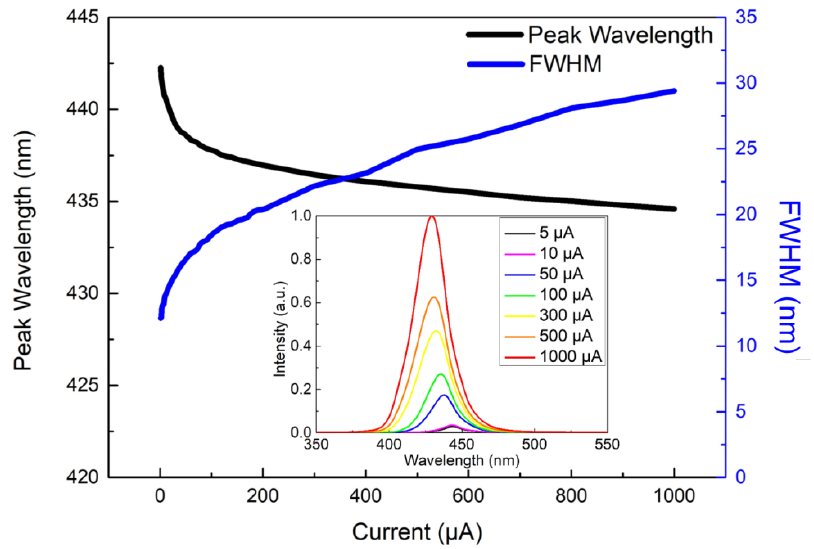
Figure 7. Peak wavelength and full width at half maximum (FWHM) as a function of injection current for a typical single pixel of the 1920 × 1080 blue MicroLED array. Inset: EL spectra at various forward currents from 5 μA to 1 mA.